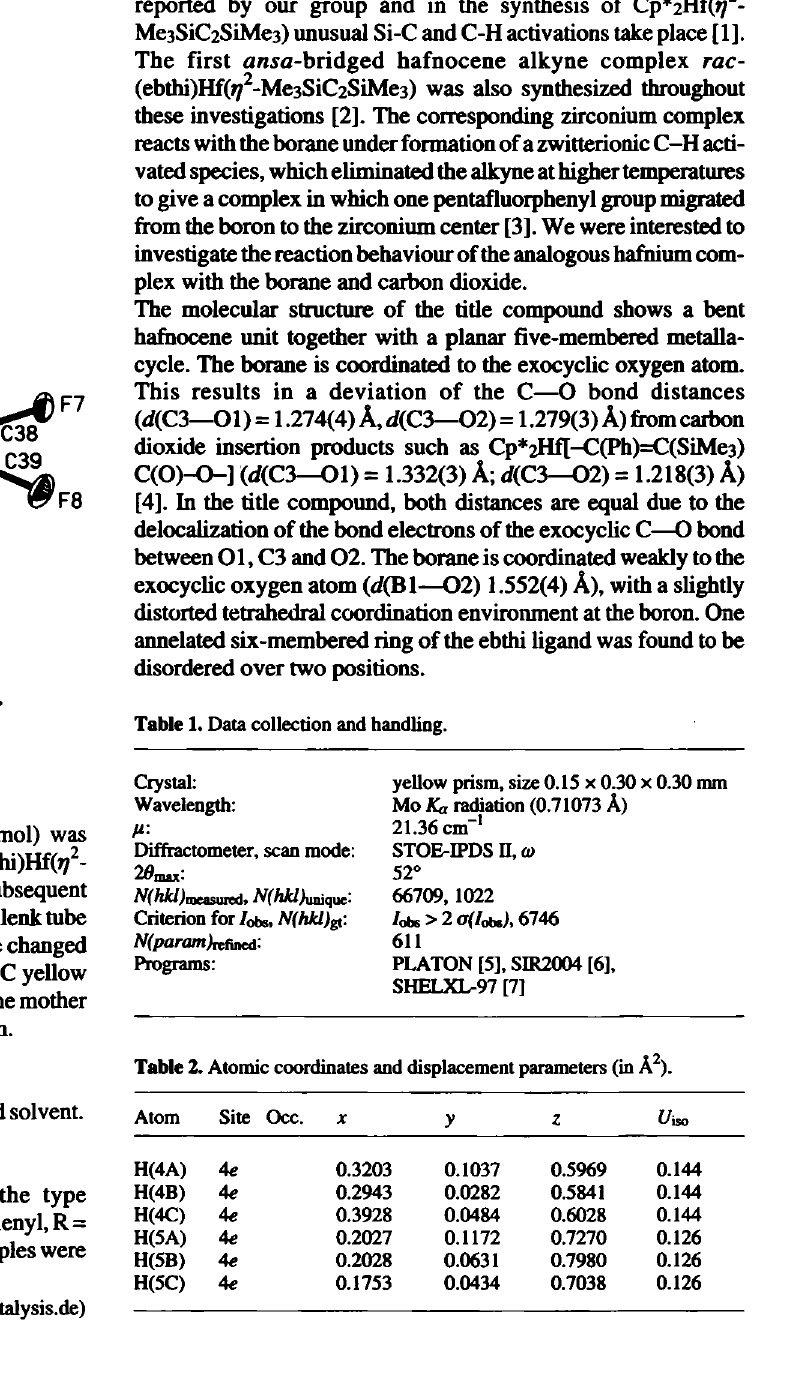
Table 2. Atomic coordinates and displacement parameters (in Â 2